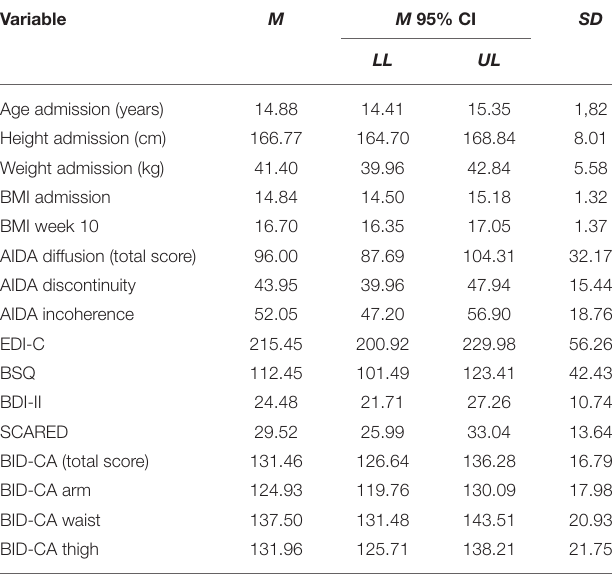
TABLE 1 | Descriptive statistics—questionnaires and behavioral